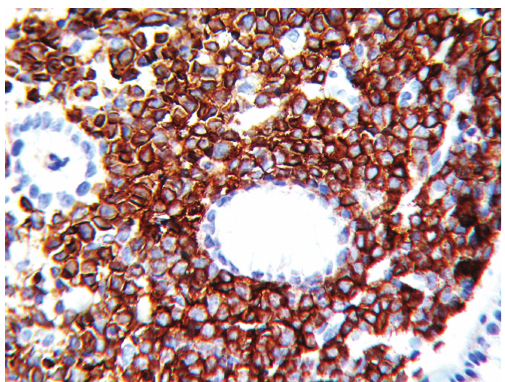
Figure 3: H&E, 400 × . Sheets of atypical round cells IHC-CD 117 marker, 400 × . Intense positivity in all atypical cells for immature myeloid marker CD 117.